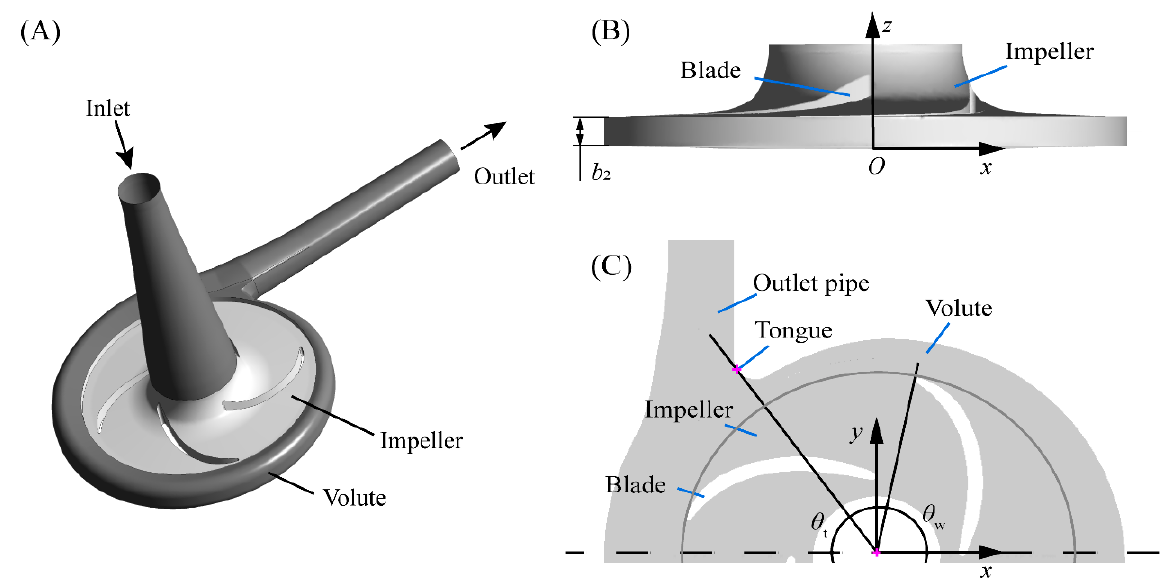
Figure 1. Schematic of the pump and notations. ( A ) Hydraulic components, ( B ) definition of height z in the meridian plane of impeller passage, and ( C ) definition of blade wrap angle θ w and volute tongue angle θ t in the mid-height plane of impeller passage ( z / b 2 = 0.5). Table 1. Main parameters of the original pump.